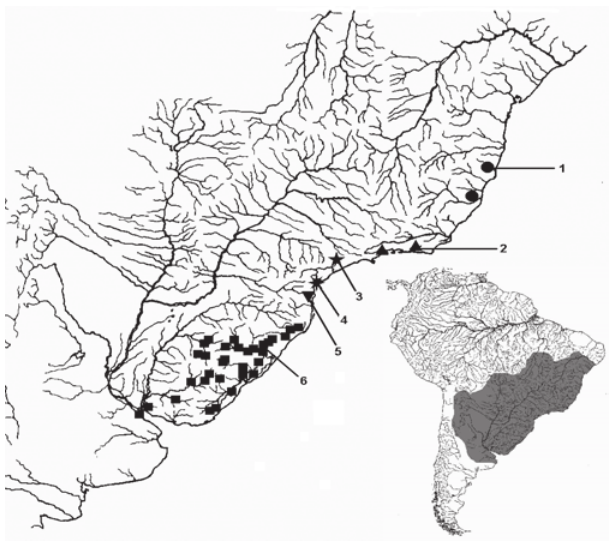
Fig. 12. Collection localities of Phalloceros ocellatus (circle, 1), P. tupinamba (triangle, 2), P. lucenorum (five-pointed star, 3), P. buckupi (eight-pointed star, 4), P. titthos (inverted tri- angle, 5), and P. caudimaculatus (square, 6). Some symbols represent more than one lot or locality. Numbers represent type localities. The inset is the range of the